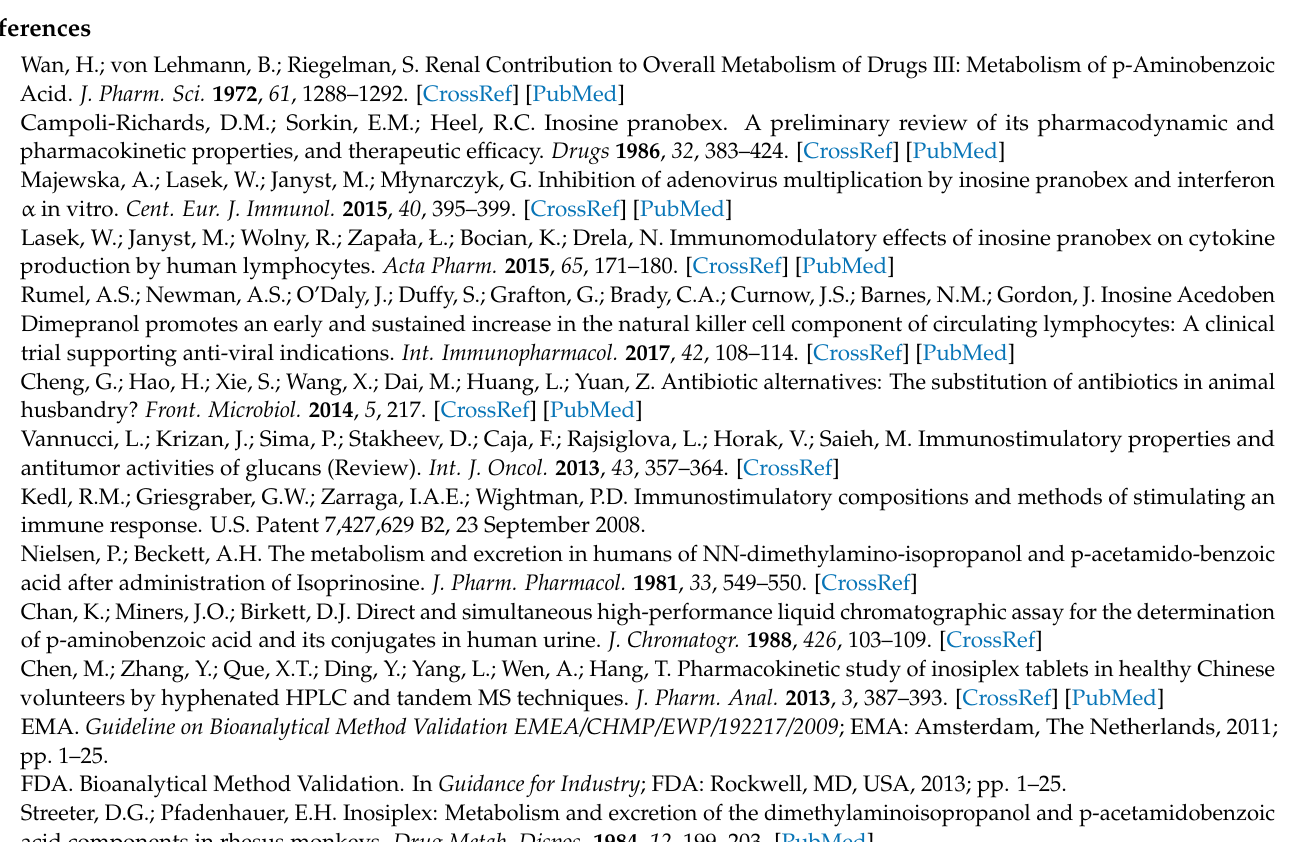
extractants. Each quality control point is the mean value calculated from six replicates. Table S2: Linearity results. Table S3: Precision and accuracy results. Table S4: The lowest limit of quantitation (LLOQ) and limit of detection (LOD) results. Table S5: Carry over test results of 4-acetamidobenzoic acid (PAcBA) and deuterium labeled (d3) 4-acetamidobenzoic acid (internal standard; IS). Table